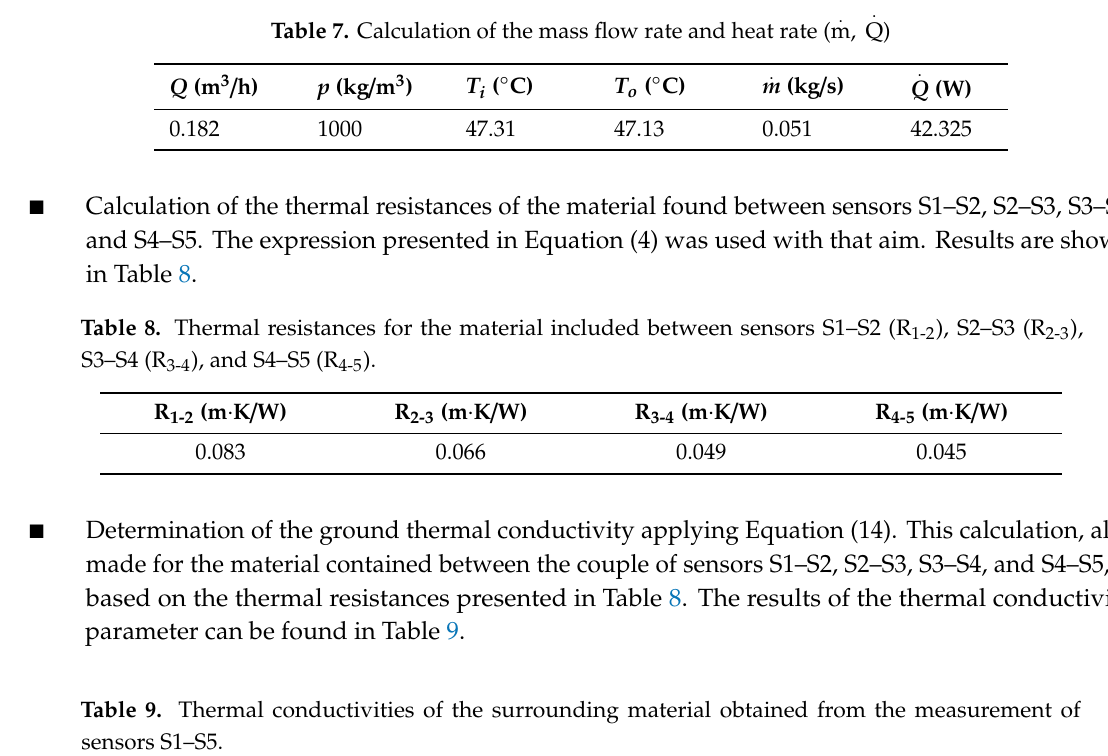
Table 7. Calculation of the mass flow rate and heat rate (